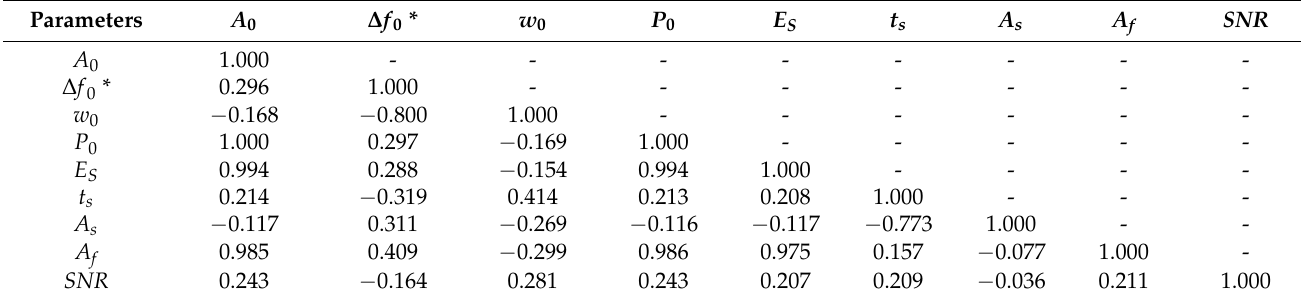
Table 3. Correlation table of all extracted features of